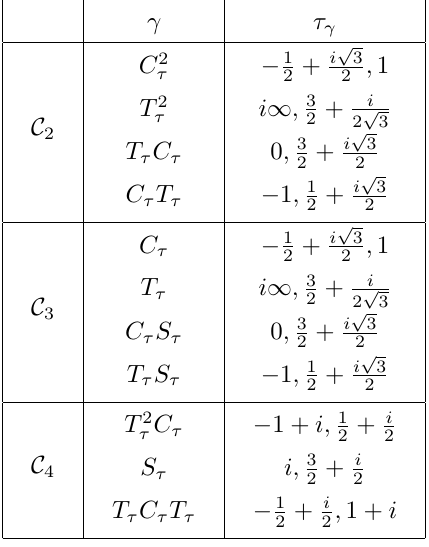
Table 2 . The non-identity elements of Γ 3 and respective